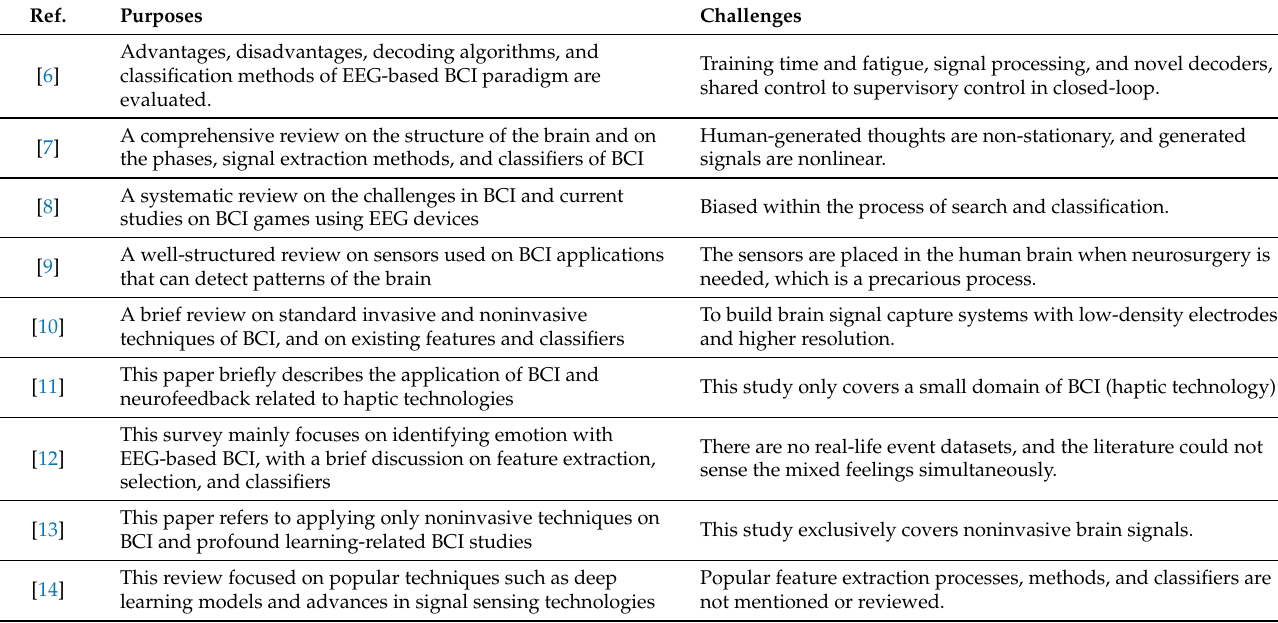
Table 1. A summary of recent surveys/reviews on various BCI technologies, signals, algorithms, classifiers, etc.